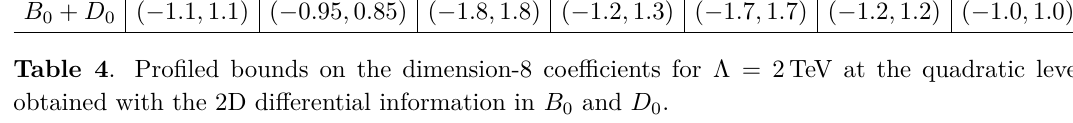
Table 3 . Individual bounds on the dimension-8 coefficients for Λ = 2 TeV at the linear and quadratic levels obtained with the 1D and 2D differential B 0 analyses, as shown in figure 3. The last column shows the impact of including D 0 in the 2D linear+quadratic case. Coeff. C 8 ,lq∂ 3 C 8 ,lq∂ 4 C 8 ,ed∂ 2 C 8 ,eu∂ 2 C 8 ,ld∂ 2